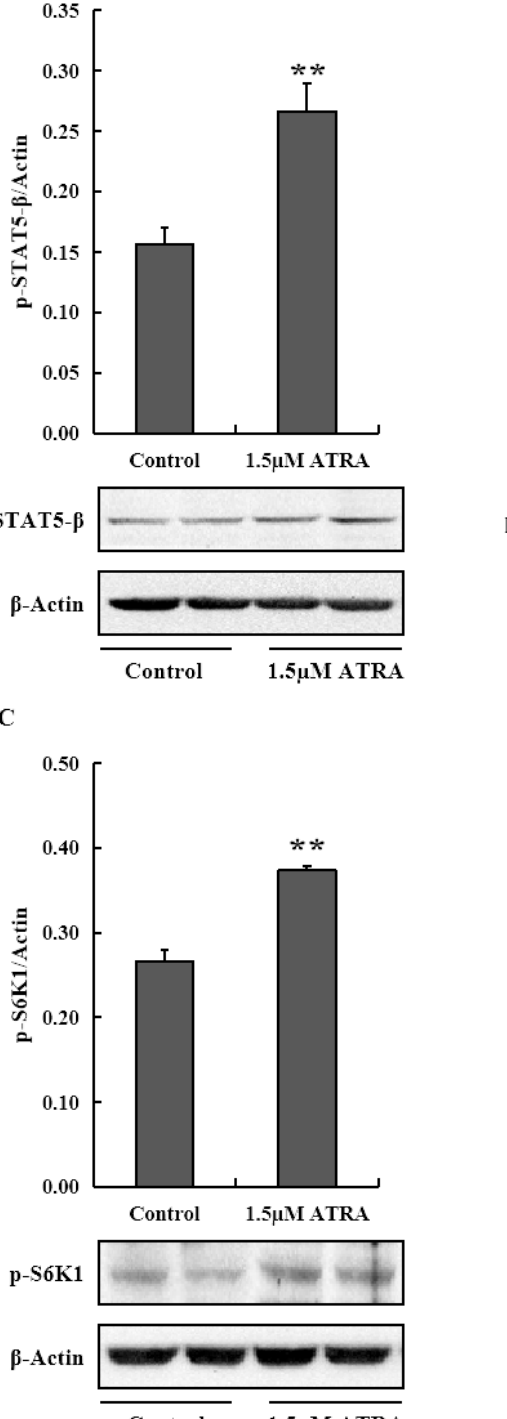
Figure 3. Protein levels of phospho-STAT5- β (A) , phospho-mTOR (B), and phospho-S6K1 (C) in differentiated MAC-T cells treated with ATRA. STAT5- β , signal transducer and activator of transcription 5 β ; mTOR, mammalian target of rapamycin; S6K1, S6 kinase beta-1; ATRA, all-trans retinoic acid. Data are mean±standard deviation (n = 3). ** Astersik indicates significant difference comparing with control